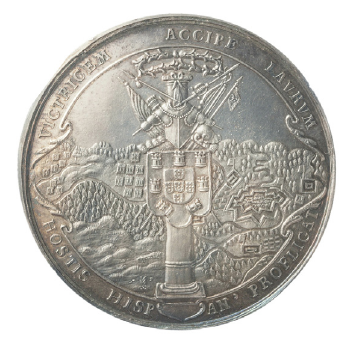
Fig. 5. The obverse of the medal minted by the Dutch